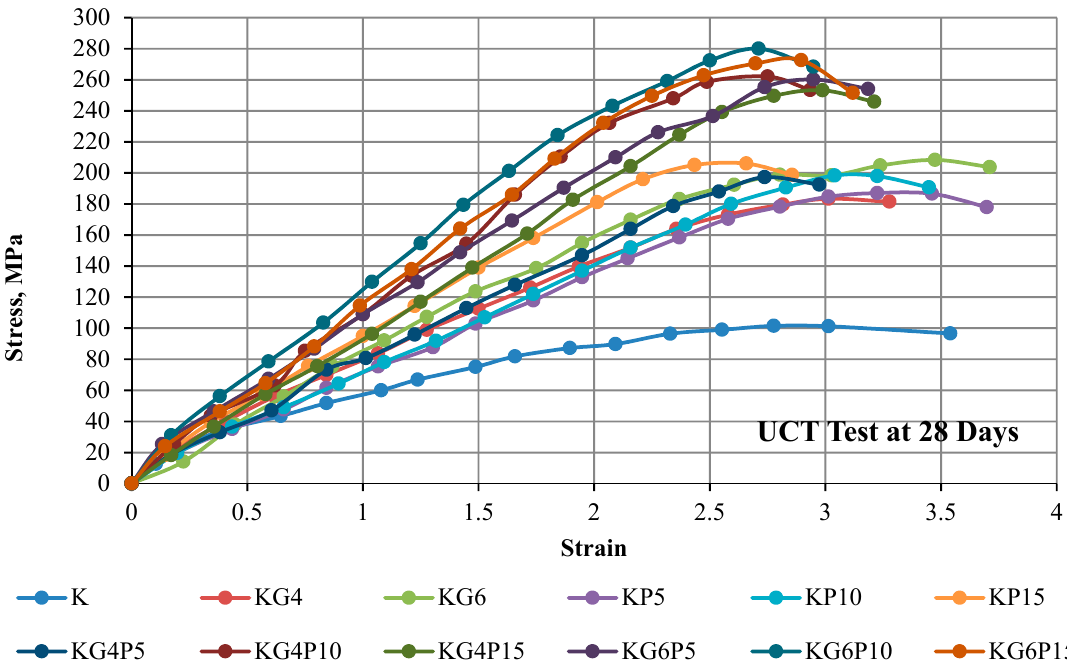
Figure 8. Stress–strain curve of kaolin and treated kaolin with gypsum and POFA tested after 28 days of curing.